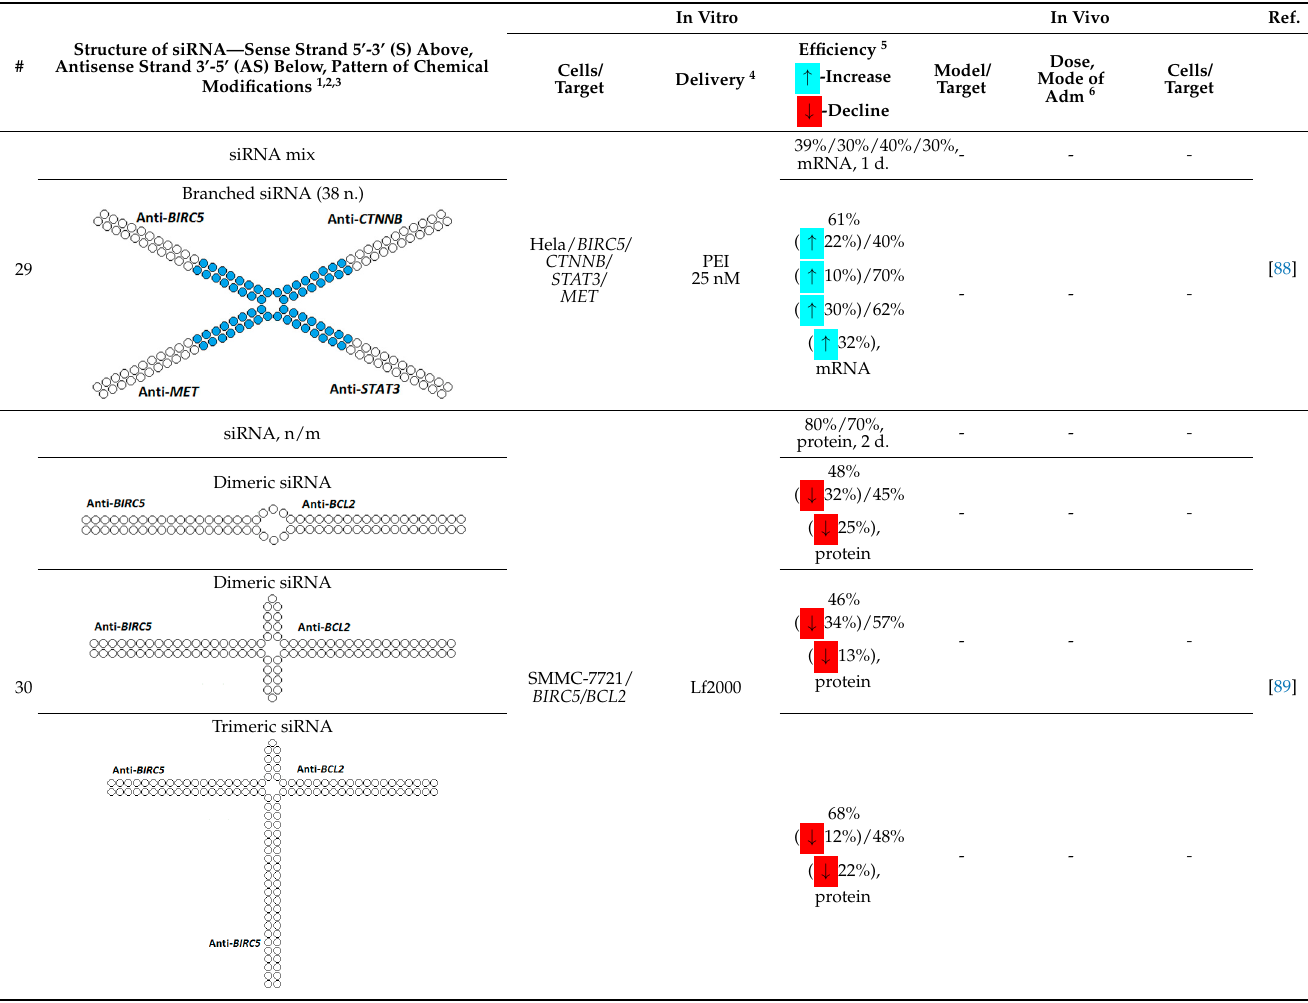
and. 3 Putative Dicer cleavage sites are indicated by black arrows. 4 “-”—delivery without transfec- tion agent, Lf2000—transfection agent Lipofectamine 2000. 5 Route of administration: i.v.—intrave- nously.